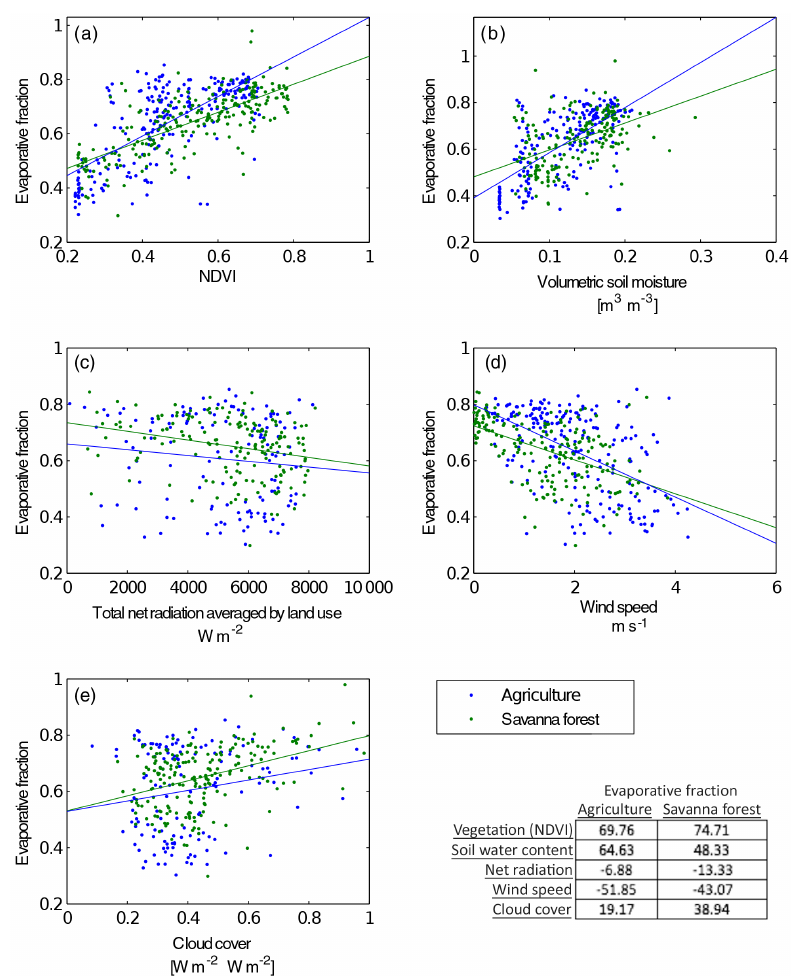
Figure 8. Daily evaporative fraction over study period for the agricultural field (blue) and the savanna forest (green) compared with the observed (a) NDVI, (b) VWC, (c) wind speed, (d) net radiation, and (e) cloud cover. In all cases, environmental variables are from the average of stations with the same land cover with the energy balance station. These plots show a better correlation with NDVI and VWC (a, b) , suggesting a moisture-limited and not a radiation-limited system. The least squares regression lines are shown for each plot. Correlations between variables are in the